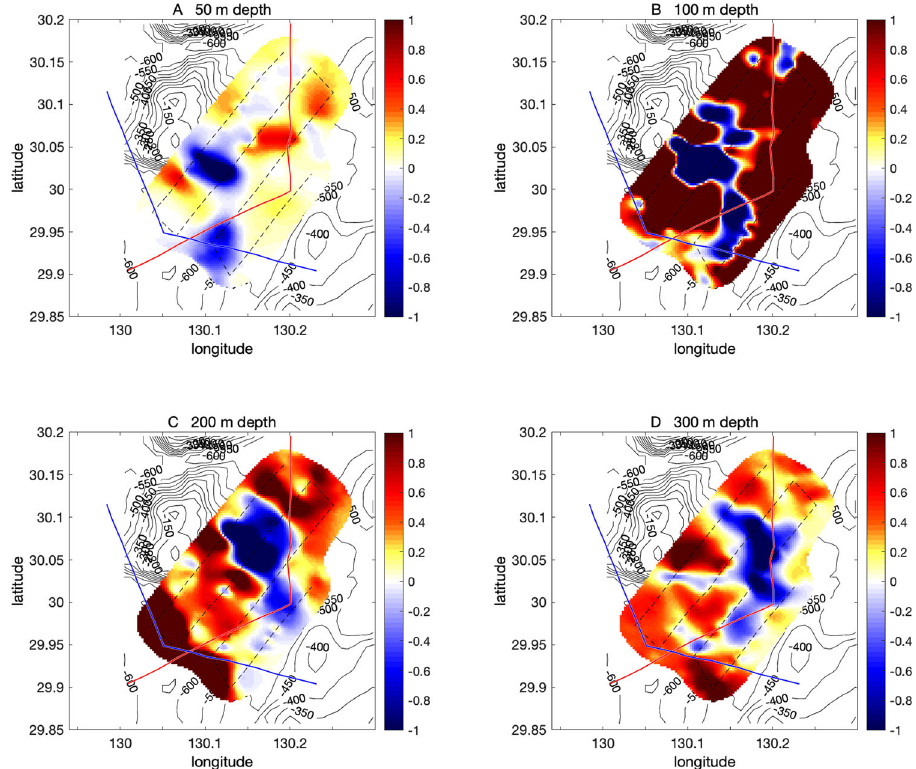
Fig. 7 Observed three-dimensional potential vorticity during November 2019 cruise. Three-dimensional PV (Eq. (3) in “ Methods ” ) sliced at ( a ) 50, ( b ) 100, ( c ) 200, and ( d ) 300 m depths (10 – 9 m – 1 s – 1 ). Solid lines indicate UVMP observation lines for (red) leg 1, starting from eastern side of the Hirase submarine rise toward south and southwestward, and (blue) leg 2, starting from western side of the rise toward south and southeastward. The broken black line indicates the ship track for the UCTD observations.